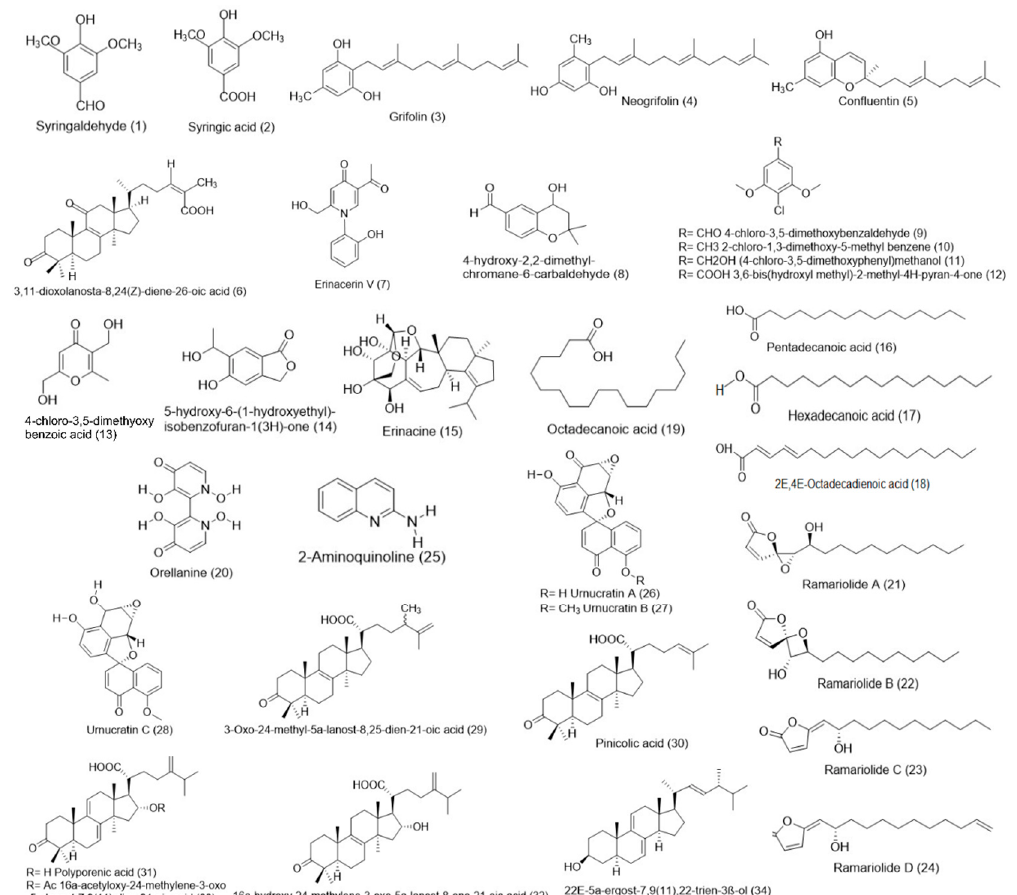
Figure 2. Structures of small molecules isolated from mushrooms native to North America.